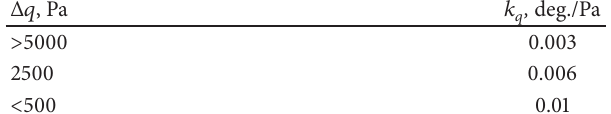
Table 2: Suboptimal gains for the maximum range Δ𝑞 = |𝑞